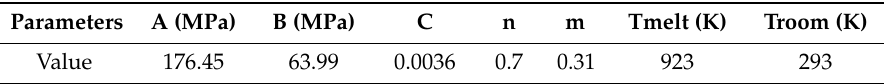
Table 2. Johnson–Cook constitutive model parameters of aluminum matrix.